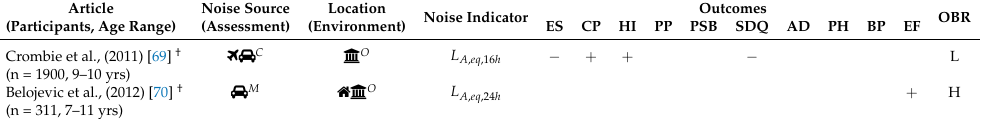
ES CP HI PP PSB SDQ AD PH BP EF